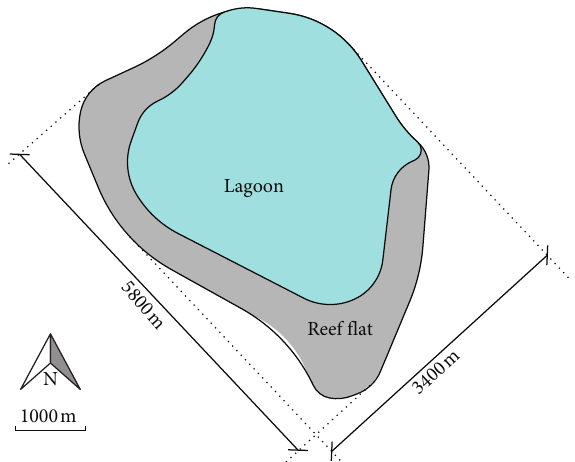
Figure 1: Local map of Zhubi Reef in the South China